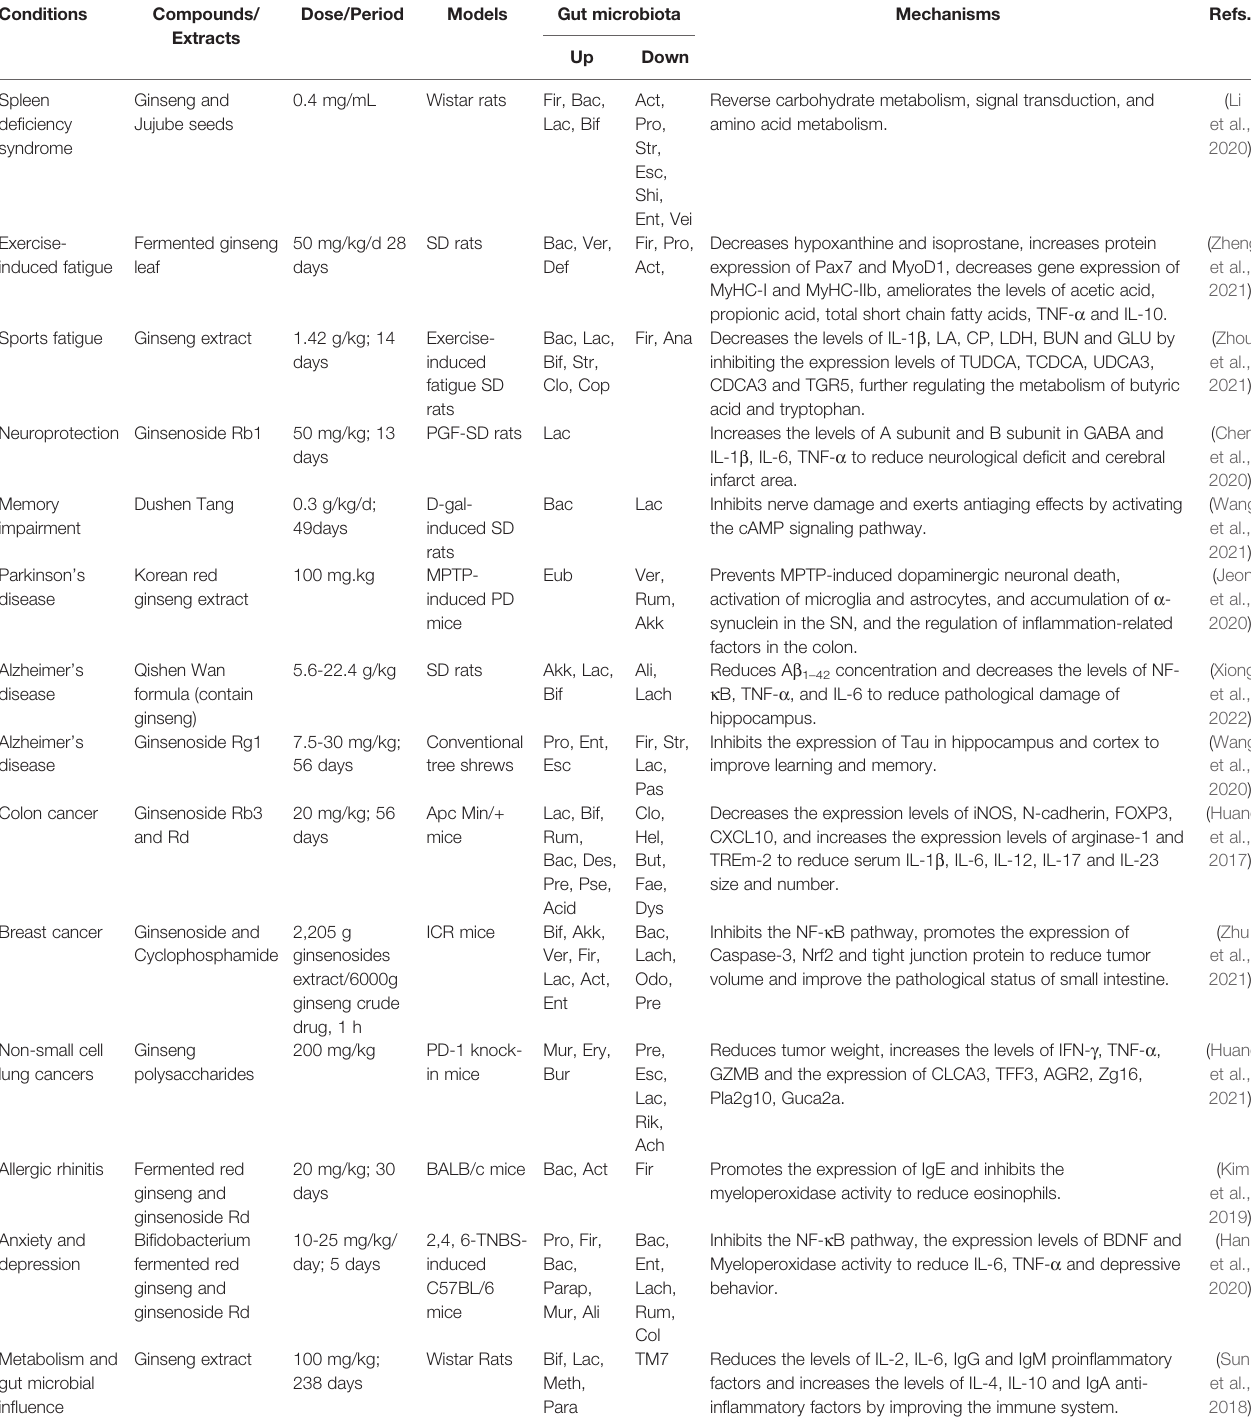
TABLE 5 | Summary of anti-other diseases activities of ginseng by regulating gut microbiota and related